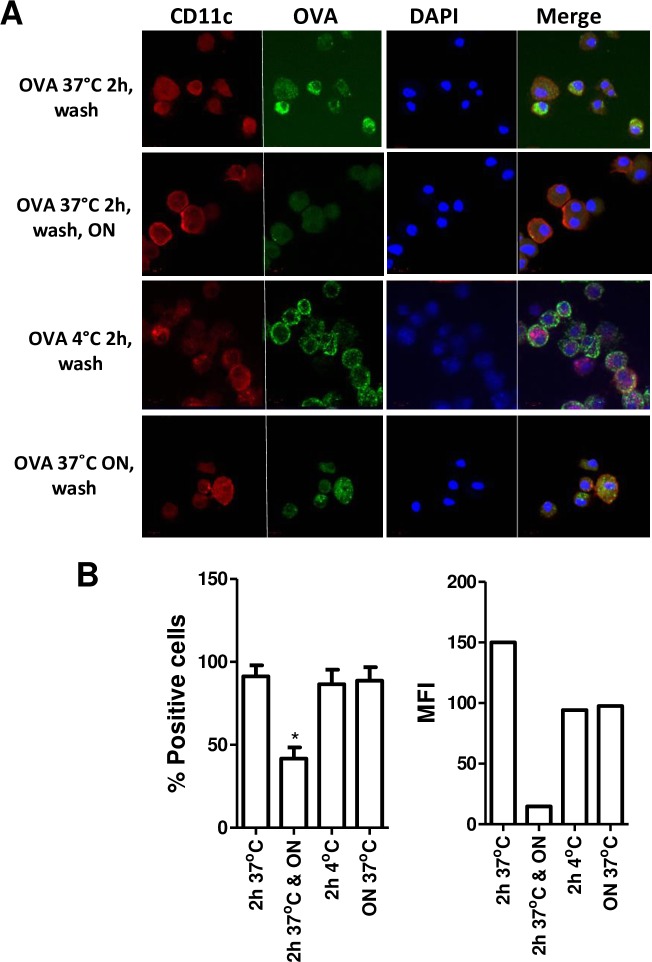
Confocal imaging and FACS analysis of allergen processing by DC10.DC10 were pulsed with FITC-labeled OVA for 2 at either 4 (OVA 4°C 2 h, wash) or 37°C (OVA 37°C 2 h, wash), and washed, and then either used as is or allowed to process their allergen overnight (OVA 37°C 2 h, wash, ON) as in Fig 5. Control DC10 were pulsed with FITC-OVA overnight at 37°C before washing (OVA 37°C ON, wash) and subsequent analysis. (A) The DC10 were then incubated for 10 min with 0.5 μg Fc block and stained with PE-anti-mouse CD11c (or isotype control antibodies), then fixed with 4% paraformaldehyde before being applied to cytocentrifuge slides and stained with the nuclear dye DAPI. Zeiss LSM 700 confocal microscope images of CD11c, FITC-OVA and DAPI-stained cells, and merged images of all three stains are presented for each treatment. (B) The fixed cells were also analyzed by FACS, with cell gating based on isotype control antibody staining; the FACS data is presented as (left panel) the percent of the cells staining positively for FITC-OVA and (right panel) the mean fluorescence intensity of FITC-OVA staining. Approximately 40% of the DC10 that had been washed and allowed to process their residual FITC-OVA displayed close to background levels of FITC staining. This data is representative of three independent experiments. Statistical analyses were performed using one-way ANOVA assays with Tukey’s post-hoc testing.